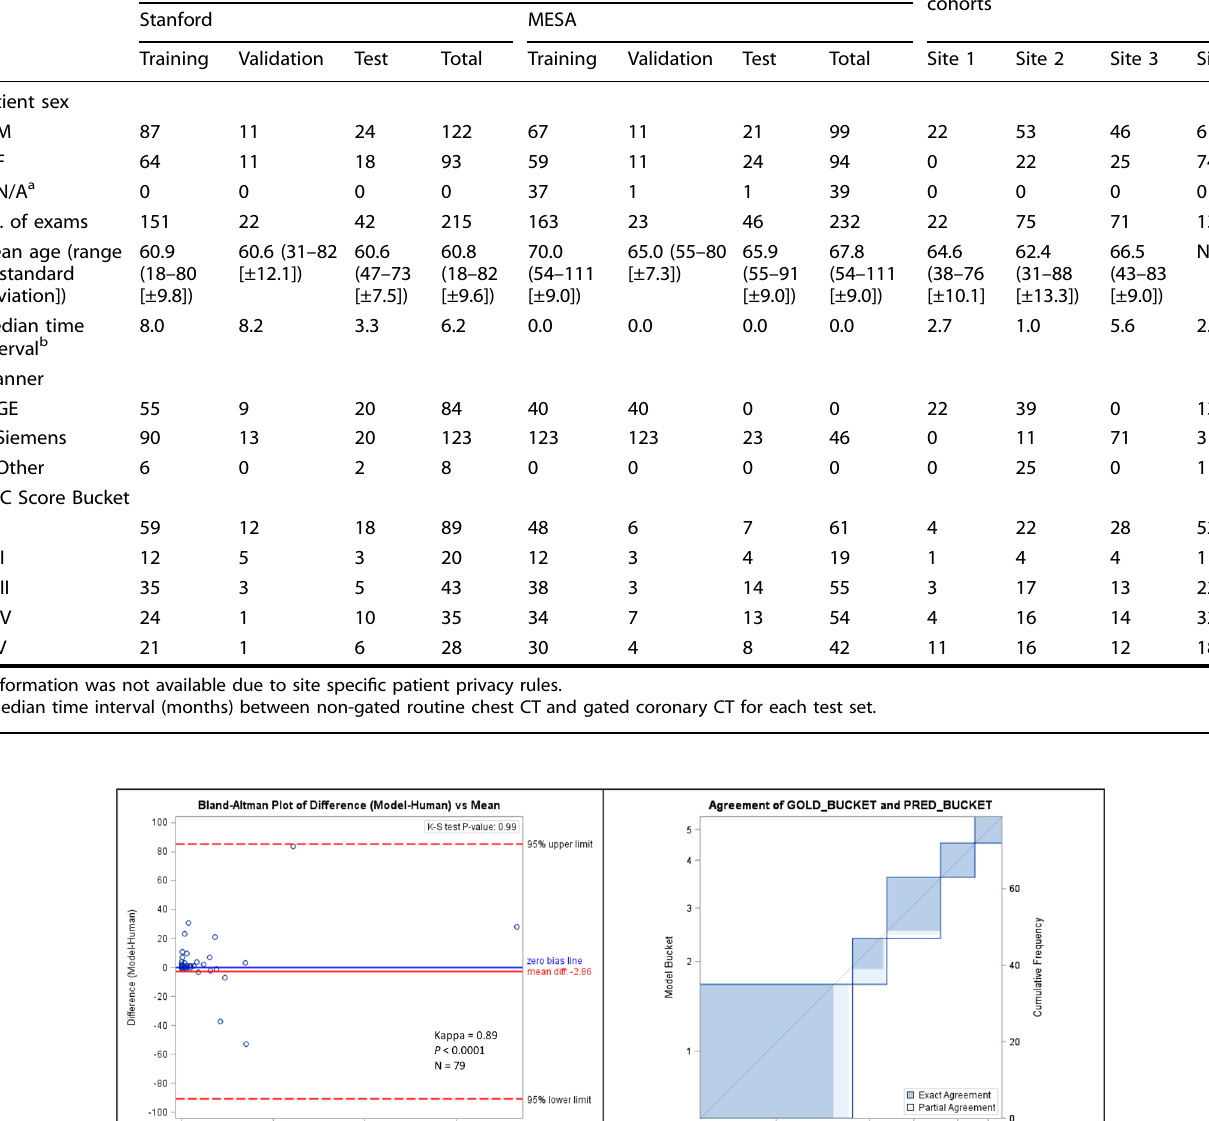
Table 2. Cohort demographics and statistics for non-gated model. Characteristic